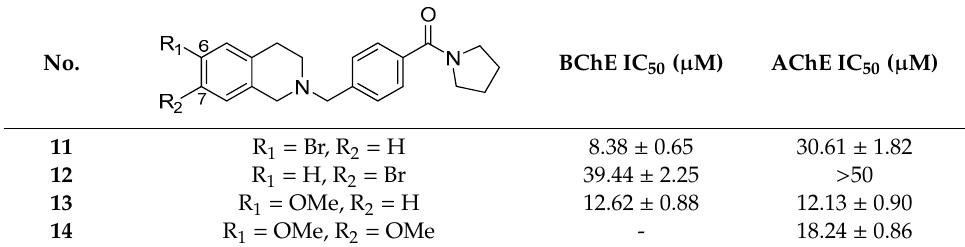
Table 2. The inhibitory activities of compounds 11 – 14 against ChEs.